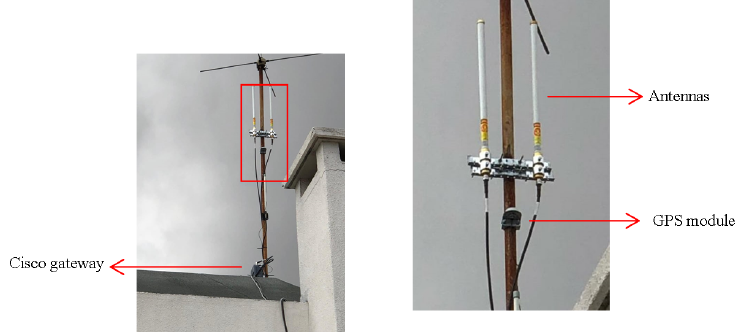
Figure 13. LoRa communication gateway infrastructure.